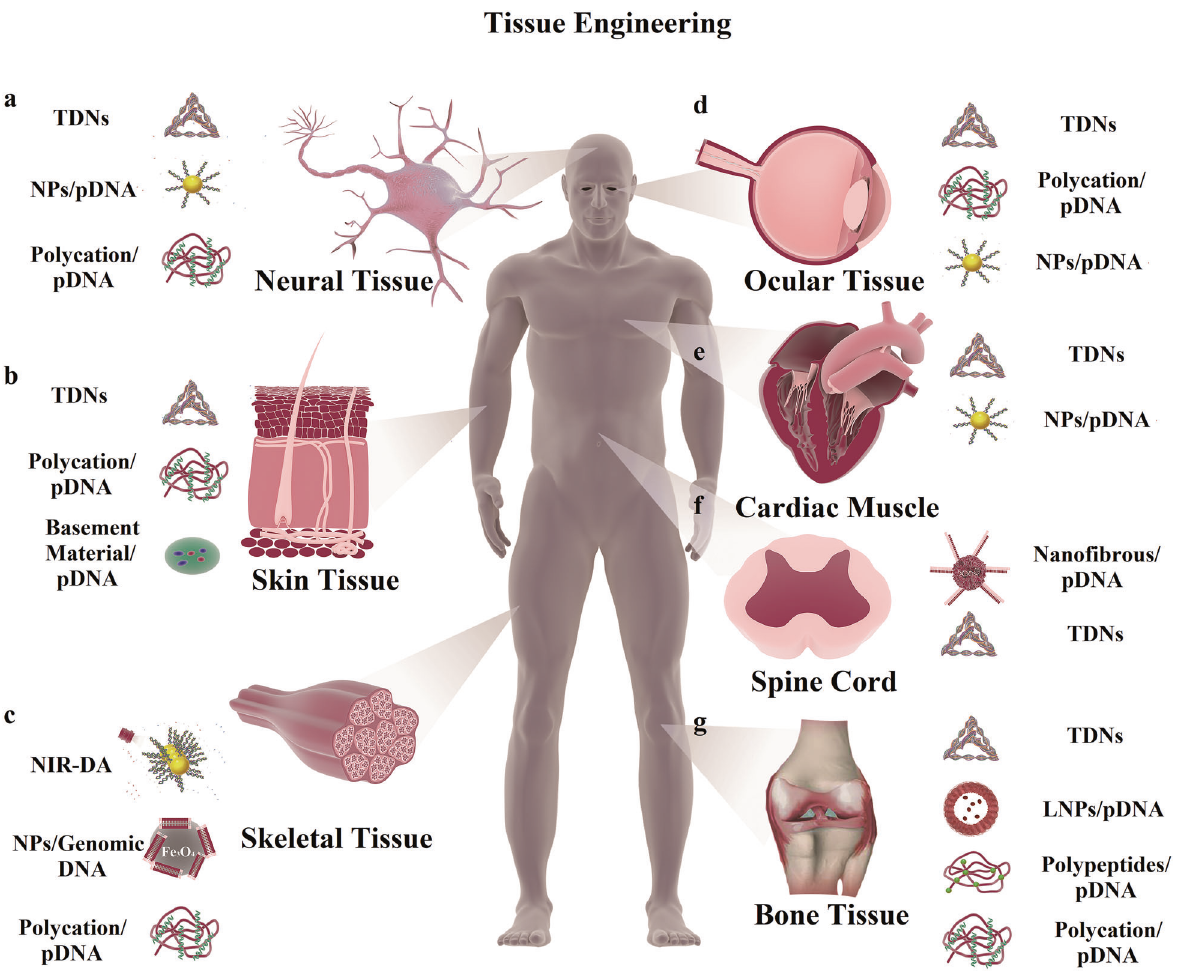
The biological applications of various DNA-based and DNA-encoding nanomaterials in tissue engineering. a , f The biological applications of different DNA-based nanomaterials in neural tissue (e.g., TDNs, NPs loading various pDNA, polycation loading various pDNA, and some nano fi brous loading pDNA). b The biological applications of different DNA-based nanomaterials in skin tissue (e.g., TDNs, polycation loading various pDNA, and some basement materials loading pDNA). c , e The biological applications of different DNA-based nanomaterials in skeletal and cardiac muscle engineering (e.g., skeletal tissue: NIR-DA, NPs loading genomic DNA, and various polycation loading pDNA; cardiac muscle: nano fi brous loading pDNA and TDNs). d The biological applications of different DNA-based nanomaterials in corneal tissue (e.g., TDNs, NPs loading various pDNA, and polycation loading various pDNA). g The biological applications of different DNA- based nanomaterials in bone tissue engineering (e.g., TDNs, LNPs loading pDNA, polypeptides loading various pDNA, and polycation loading various pDNA) bone regeneration. 276 – 280 Previous studies reported that the delivery of FGF-2 and BMP-2 genes could upregulate the transcription of Runx2 and osteocalcin, 281,282 and Salem et al. reported that non-viral gene delivery of FGF-2 and BMP-2 via pDNA could attenuate the harmful effects of diabetes mellitus on bone regeneration at the defect sites. 254 PLGA was used to encapsulate the novel nanoparticles that consisted of polyethylenimine (PEI) and human pDNA- BMP-2 to create p BMP-2 /PEI nanoparticles for bone formation. 283,284 The BMP-7 and VEGF-A genes were encoded into the injectable DNA-loaded nano-calcium phosphate paste, and the nanocomplex was regarded as bioactive bone substitution material. 256 The DNA-loaded bone paste encoding with BMP-7 and VEGF-A showed enhanced regeneration of bone volume and signi fi cantly faster healing in critical site of bone loss at the early stages. 256 The DNA-loaded nanoparticles could release DNA, resulting in cell transfection, and then promote the expression of BMP and VEGF in bone cells. 285 Takanche et al. found that pDNA- c-myb conjugated with chitosan-gold nanoparticles (Ch-GNPs/ c-myb ) could suppress osteoclastogenesis and promote Signal Transduction and Targeted Therapy (2021)